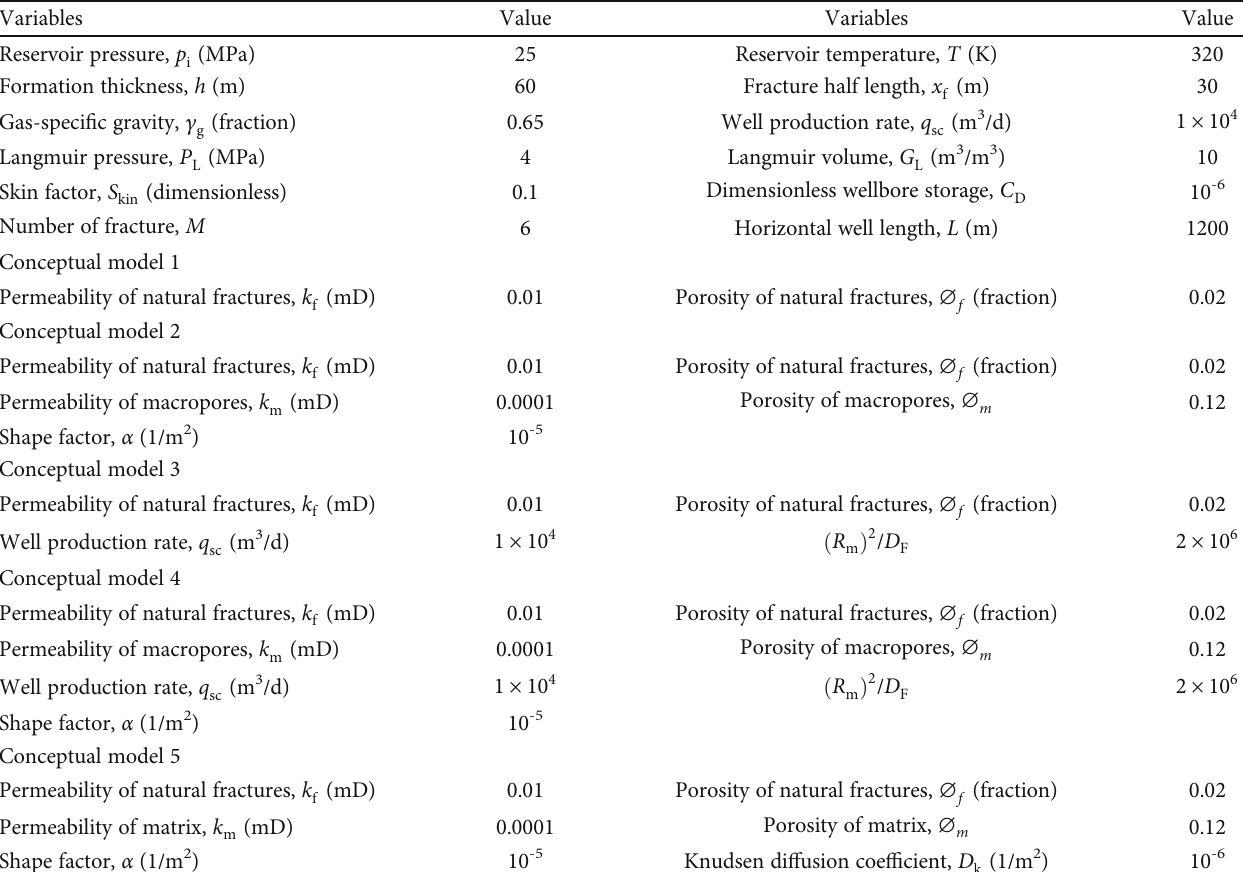
Table 3: Parameters used for the